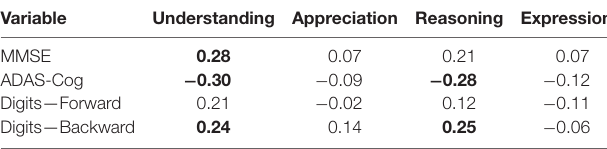
TABLE 3 | Correlations between cognitive variables and clinical competence. Variable